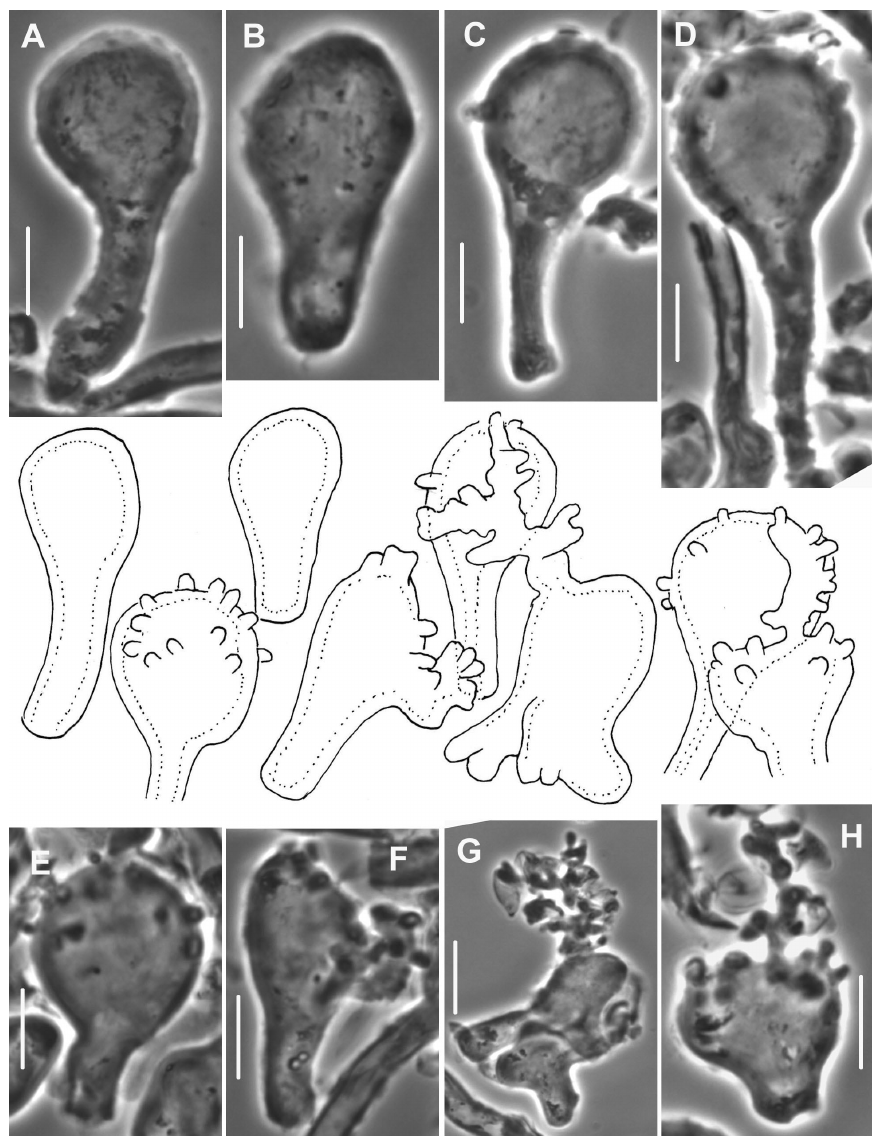
Figure 29. Mycetinis curraniae . Inflated pileipellis elements. A, B Structures minutely roughened but without papillate outgrowths C, D Structures with few, papillate outgrowths E, F Papillate outgrowths larger, more complex G, H Outgrowths complex, repeatedly rebranched. Line drawings represent photo- graphs, not to scale. Standard bars = 10 µm. ZT 949